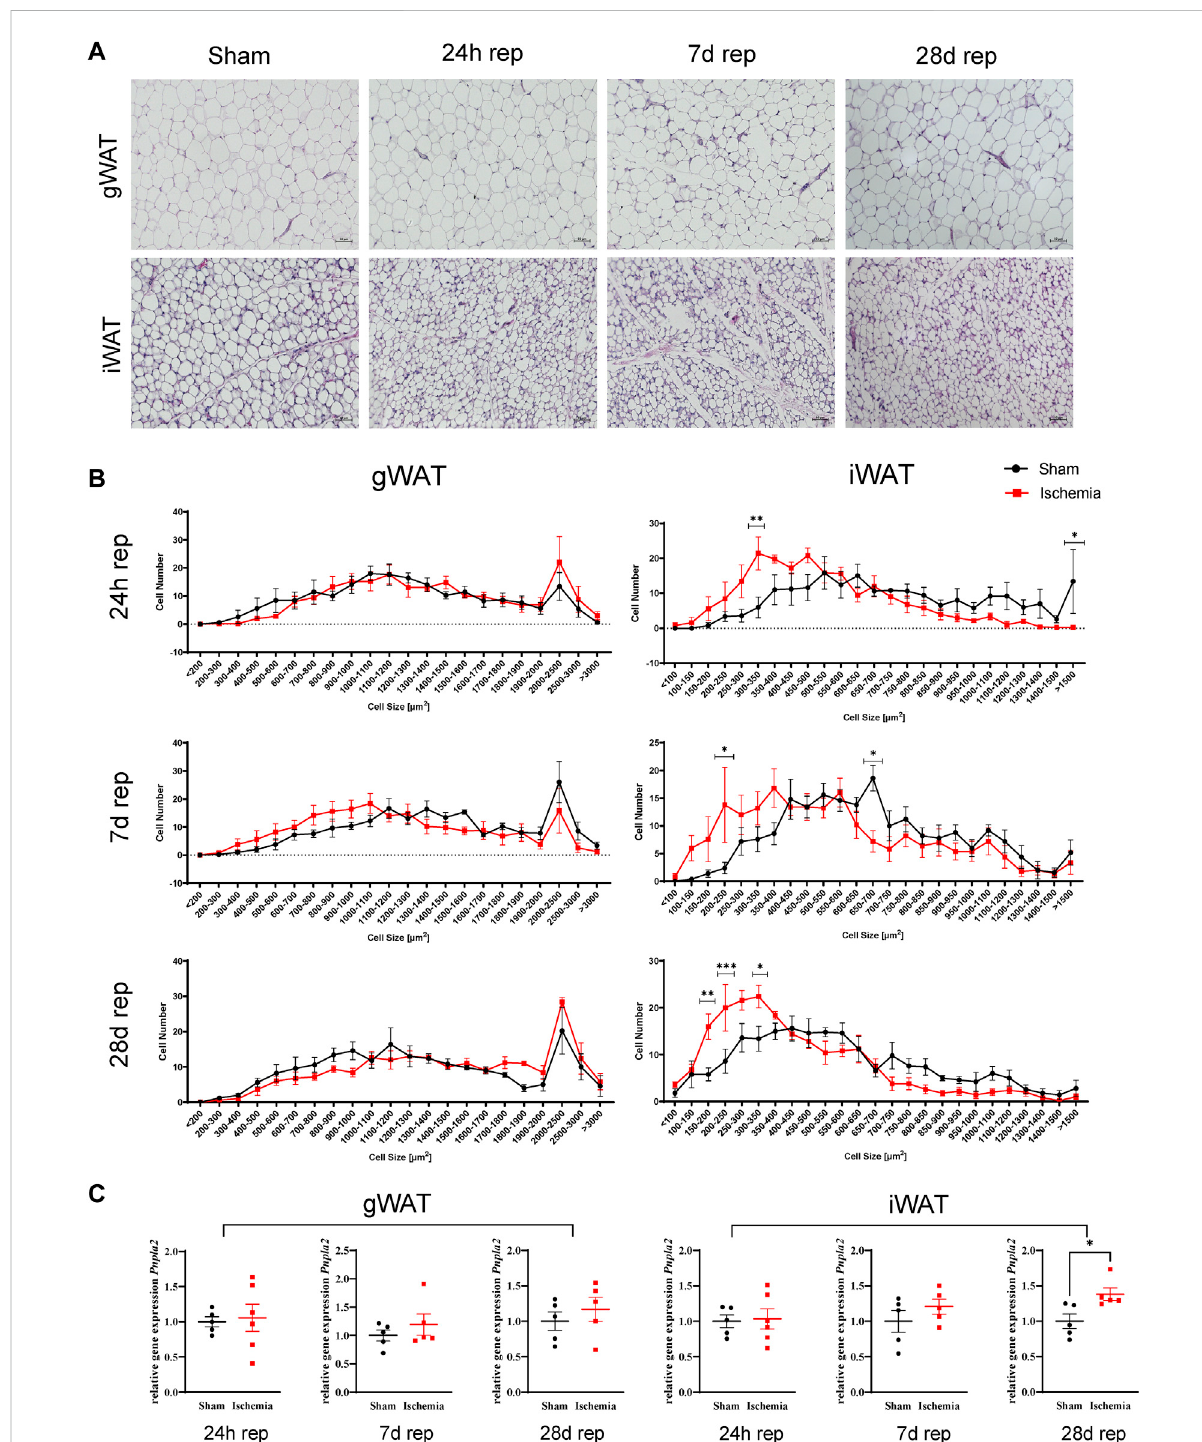
FIGURE 2 Cardiac I/R reduces adipocytes size predominantly in iWAT (A) Hematoxylin and Eosin (H&E) staining of gWAT and iWAT from sham operated animals (24 h) and after 60 min ischemia and 24h, 7, and 28 days of reperfusion. (B) Cell size distribution of adipocytes from gWAT andiWATafter24 h,7,and28 daysofreperfusion. (C) Relativegeneexpressionof Pnpla2 ingWATandiWATafter24 h,7,and28 daysofreperfusion. n = 5 – 6. Data are mean± SEM, 2-Way-ANOVA (B) or unpaired, two-tailed t -test (C) , * p < 0.05, ** p < 0.01, *** p <